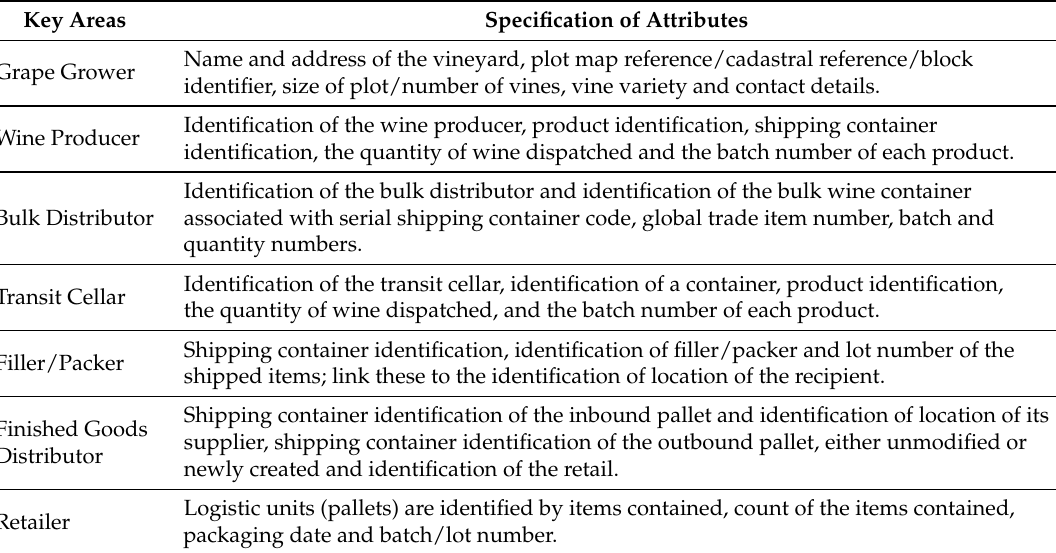
working group [16]. Each area is associated with relevant GS1 standards to be